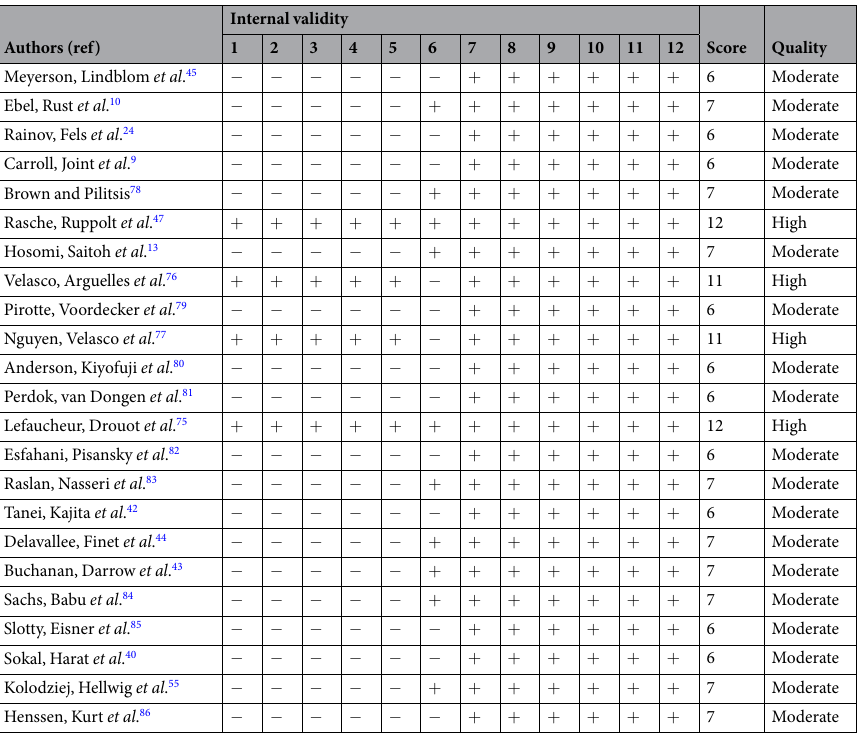
Table 1. Quality assessment of the individual papers. 1. Was the method of randomization adequate? 2. Was the treatment allocation concealed? 3. Was the patient blinded to the intervention? 4. Was the care provider blinded to the intervention? 5. Was the outcome assessor blinded to the intervention? 6. Was the dropout rate described and acceptable? 7. Were all randomized participants analyzed in the group to which they were allocated? 8. Are reports of the study free of suggestion of selective outcome reporting? 9. Were the groups similar at baseline regarding the most important prognostic indicators? 10. Were co-interventions avoided or similar? 11. Was the compliance acceptable in all groups? 12. Was the timing of the outcome assessment similar in all groups? (Questions derived from 60,61,72–74 ). + , criterion achieved; − , criterion not achieved; ∗ , assessors initially disagreed High [ ≥ 10/12]: Where criteria were not fulfilled, the conclusions of the study or review are thought very unlikely to have been altered. Moderate [6–9/12]: Where criteria were not fulfilled, the conclusions of the study or review are thought unlikely to have altered the conclusions. Low [6/12]: Where criteria were not fulfilled, the conclusions of the study or review are thought likely or very likely to alter had those criteria been